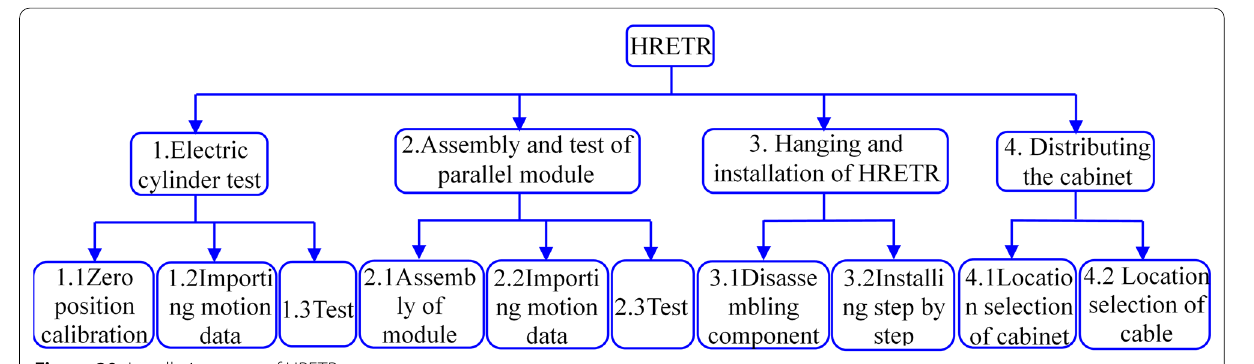
Figure 20 Installation steps of